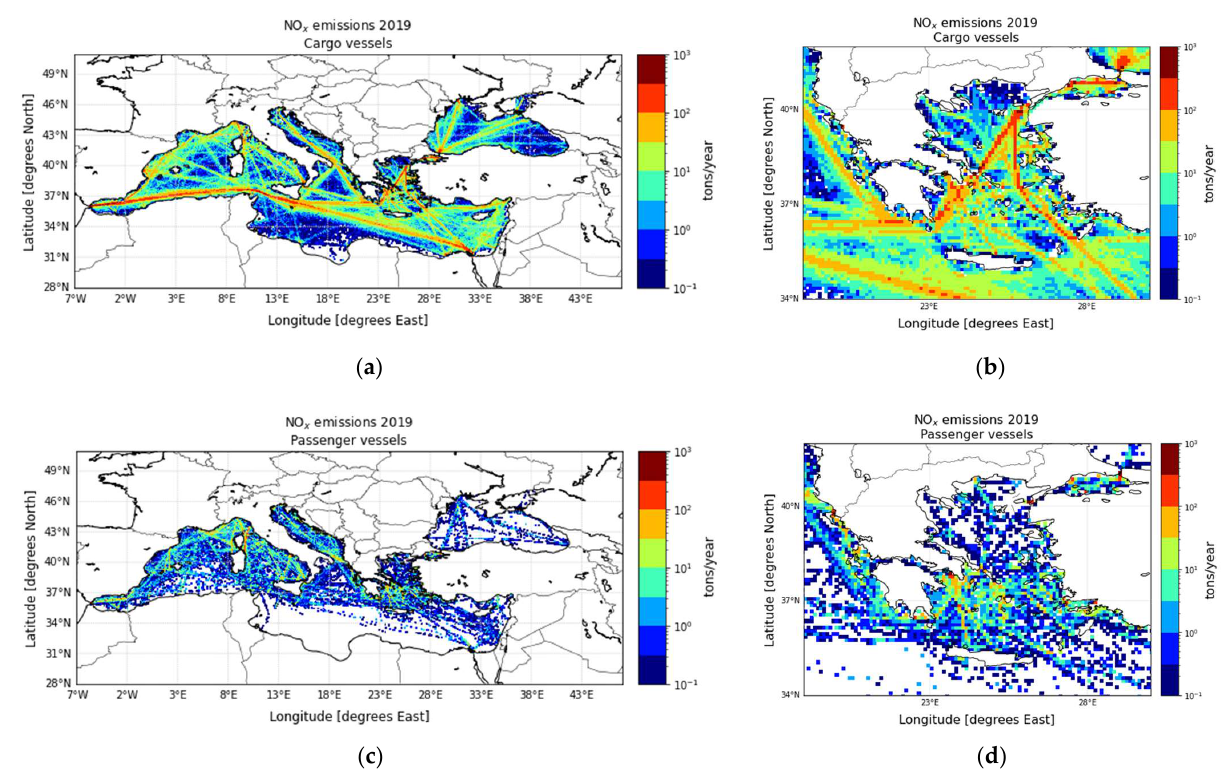
Figure 5. CAMS-GLOB-SHIP NO X emissions (in tons per year) classified according to the vessel density per vessel type: ( a ) Cargo vessels in the Mediterranean and the Black Sea; ( b ) Cargo vessels in the Greek domain; ( c ) Passenger vessels in the Mediterranean and the Black Sea; ( d ) Passenger vessels in the Greek domain.